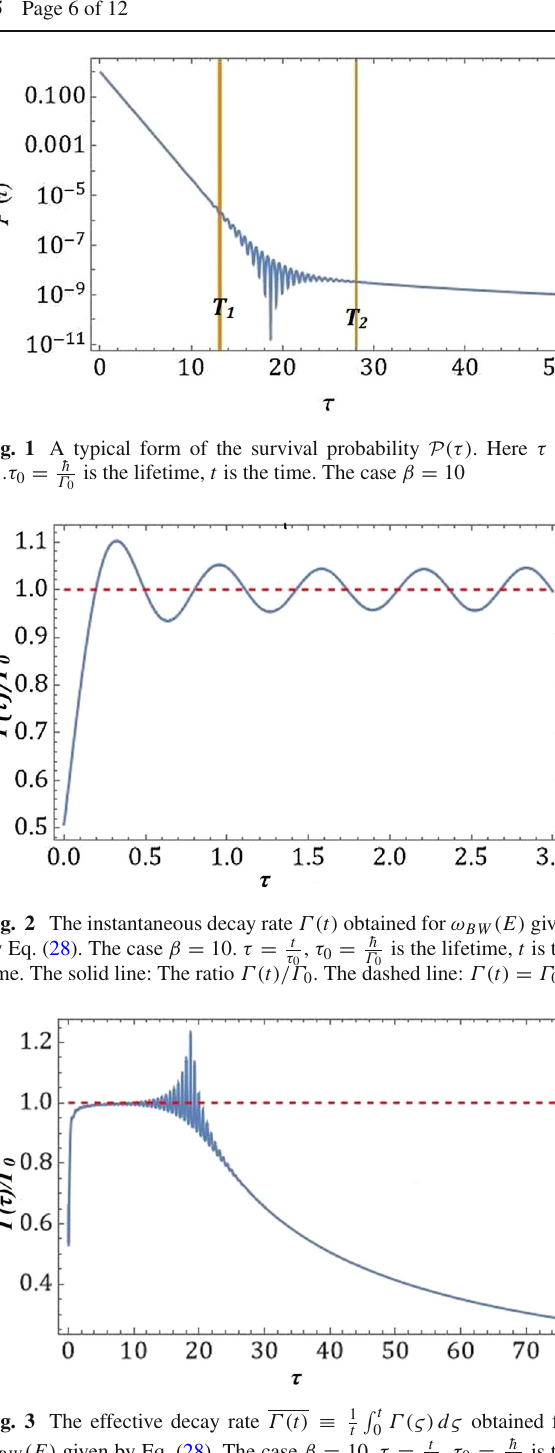
Fig. 3 The effective decay rate Γ ( t ) ≡ 1 ( E ) given by Eq. (28). The case β = 10. τ = t ω BW lifetime, t is the time. The solid line: The ratio Γ ( t )/Γ 0 . The dashed line: Γ ( t ) = Γ 0